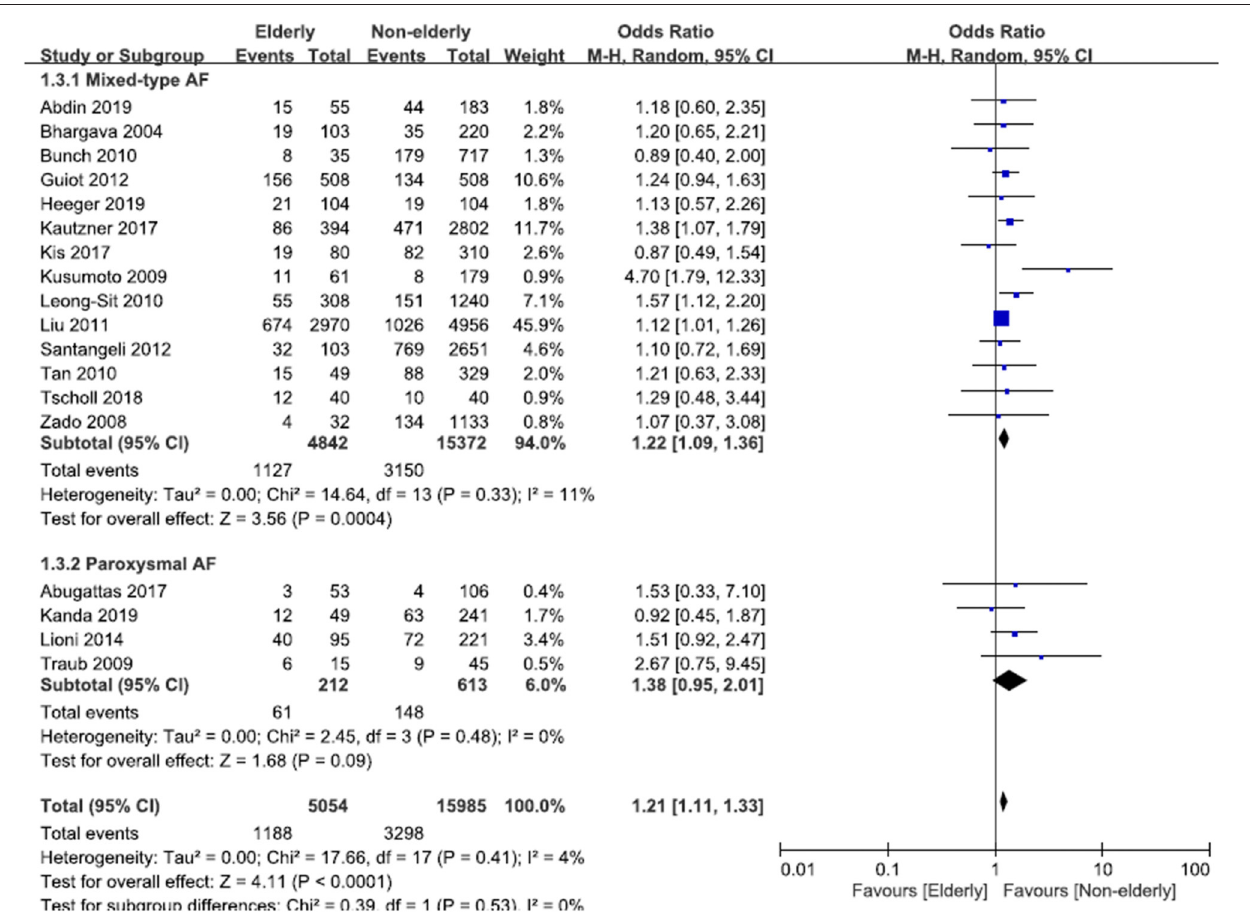
FIGURE 4 | Forest plots of the OR of recurrent AF or ATA after ablation for mixed-type AF or paroxysmal AF between the elderly and non-elderly groups from 18 studies.